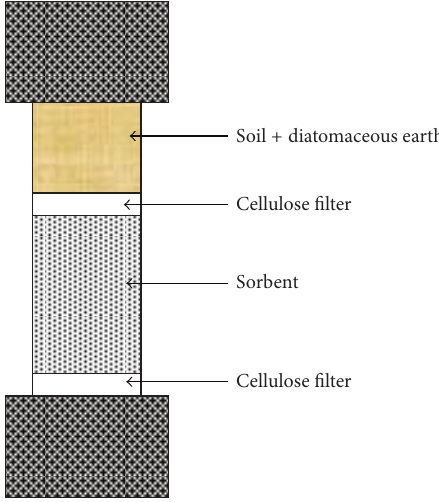
F 1: Packing of the PLE extraction